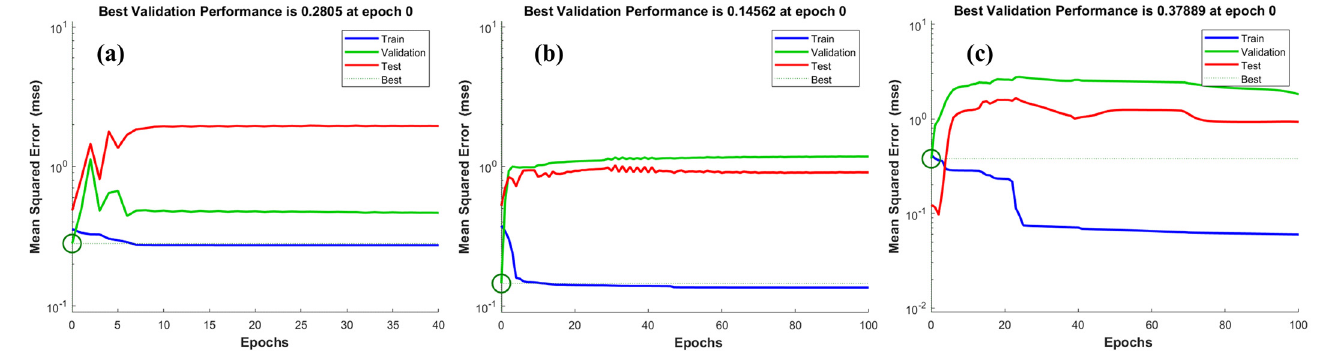
Figure 7. Validation performance curves of UCS at ( a ) M1, ( b ) M2, and ( c ) M3.